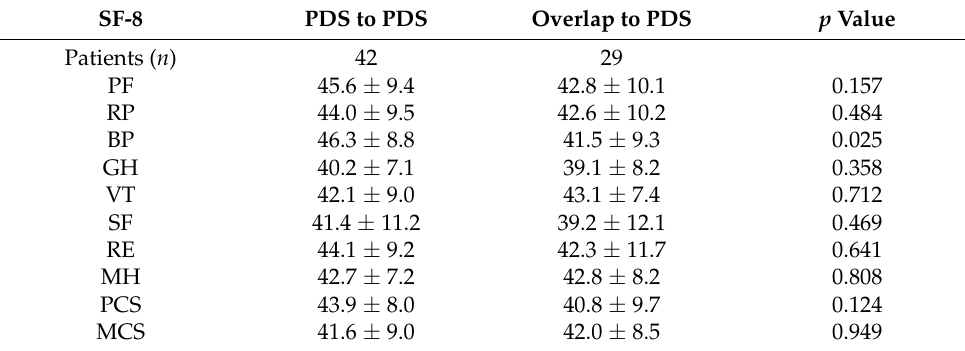
Table 3. HR-QOL (PDS to PDS vs. overlap to PDS).